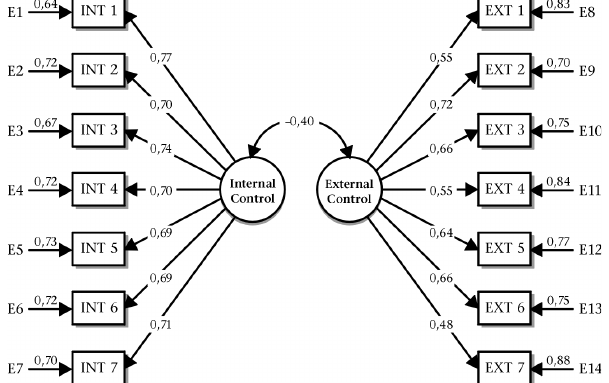
Figure 6: Standardised estimated parameters of the PIB/ SPEEX Motivation Index for the White group T ABLE